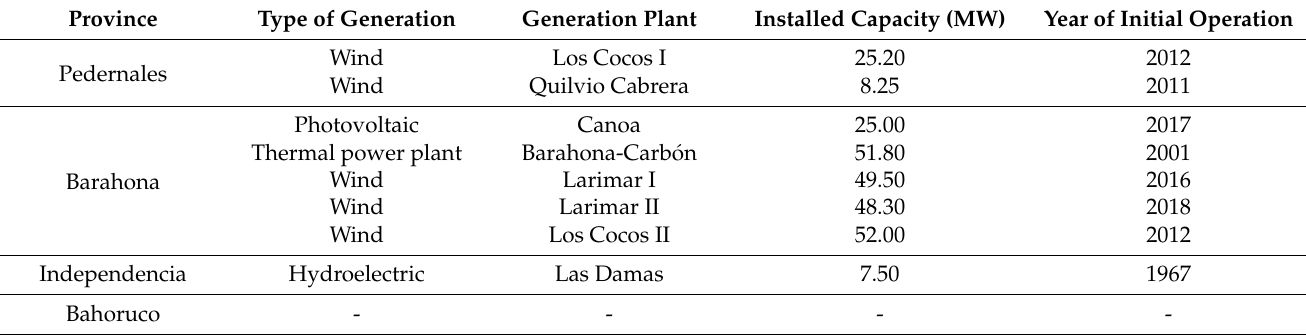
Table 4. Generation plants in the Enriquillo Region.